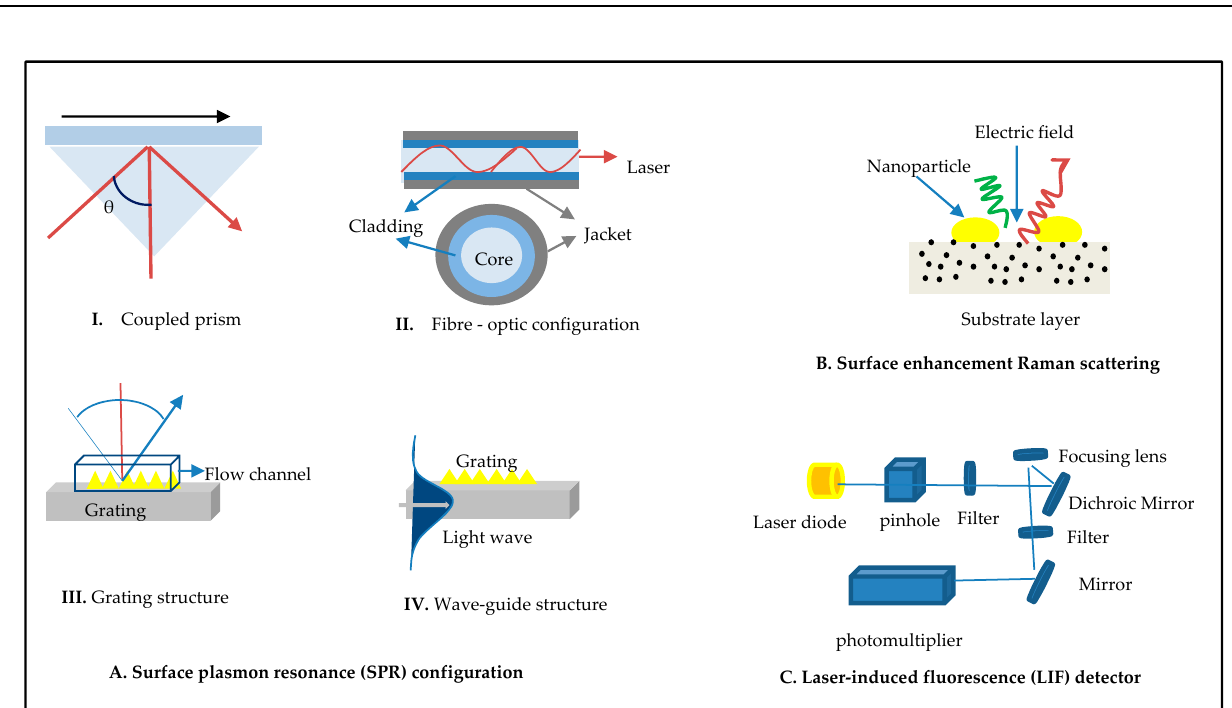
Figure 4. Illustration of light technologies’ structures: (A) surface plasmon resonance (SPR) configuration, (B) surface enhancement Raman scattering, and (C) laser-induced fluorescence (LIF) detector.